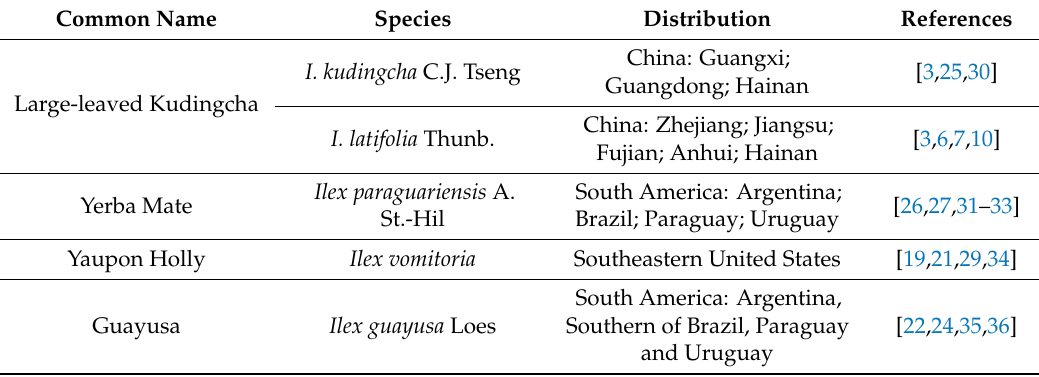
Table 1. Distribution of the most commonly consumed species of the genus Ilex